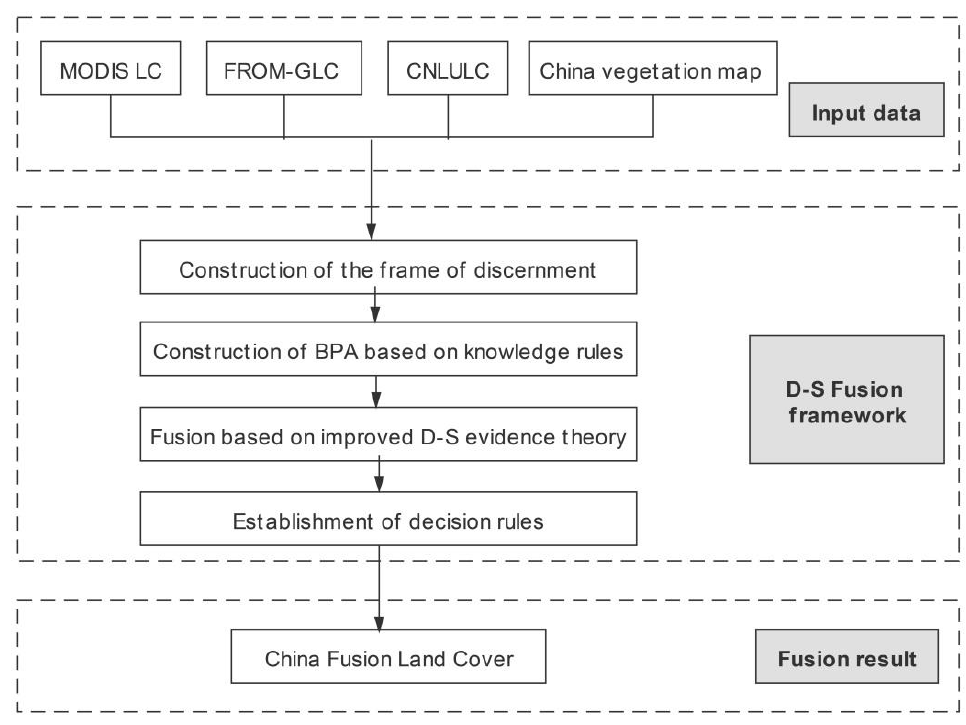
Figure 2. The flow chart of the fusion process.